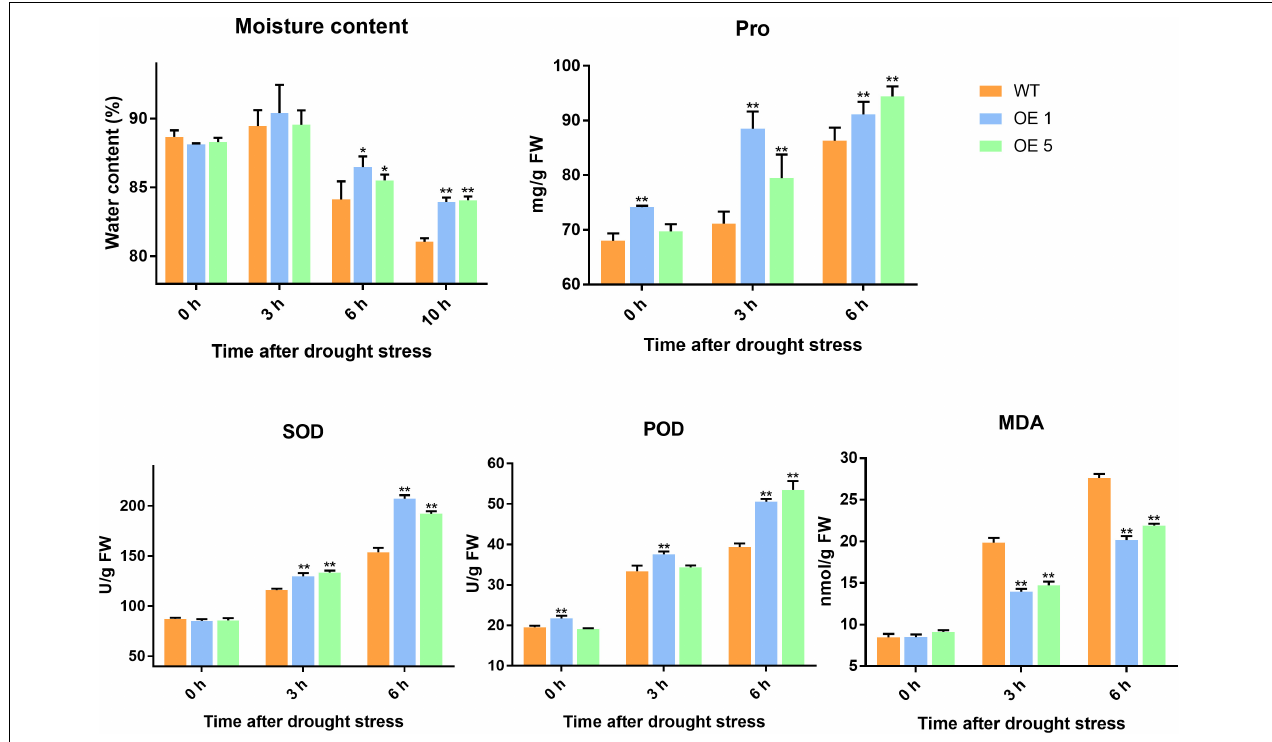
FIGURE 6 | Water content, Pro content, SOD activity, POD activity, and MDA of WT and OE plants. Error bars represent the SD of triplicate experiments. Vertical bars with * and ** represent significant differences compared with WT at each time point, analyzed by one-way ANOVA ( P ≤ 0.01**/0.05*).